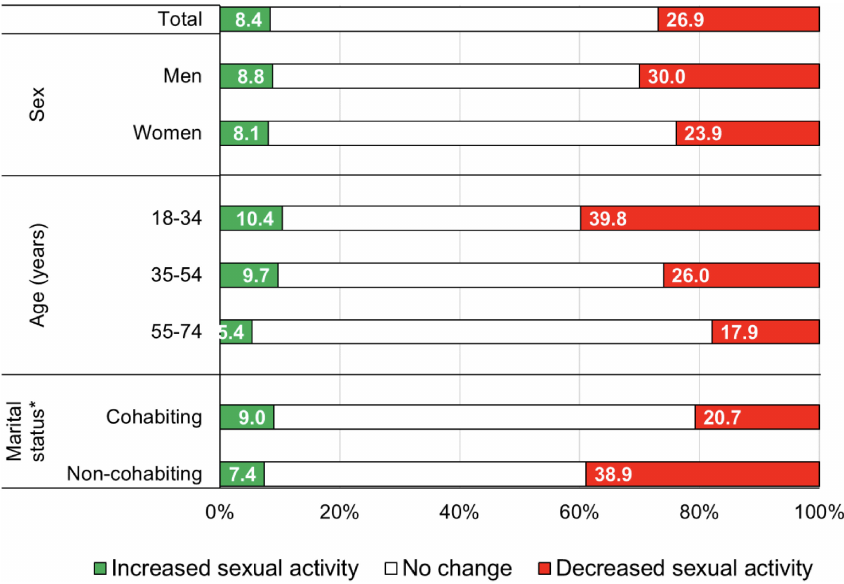
Figure 1. Distribution of 6,003 Italians by change in sexual activity during the COVID-19 lockdown, overall and in strata of marital status. Italy, 2020. “ Cohabiting ” ( N = 3,949) includes participants reporting they were married or they were living with the partner; “ Non-cohabiting ” ( N = 2,054) includes participants reporting they were divorced or separated (19.2%), widowed (5.6%), or single (75.2%). COVID-19, coronavirus disease